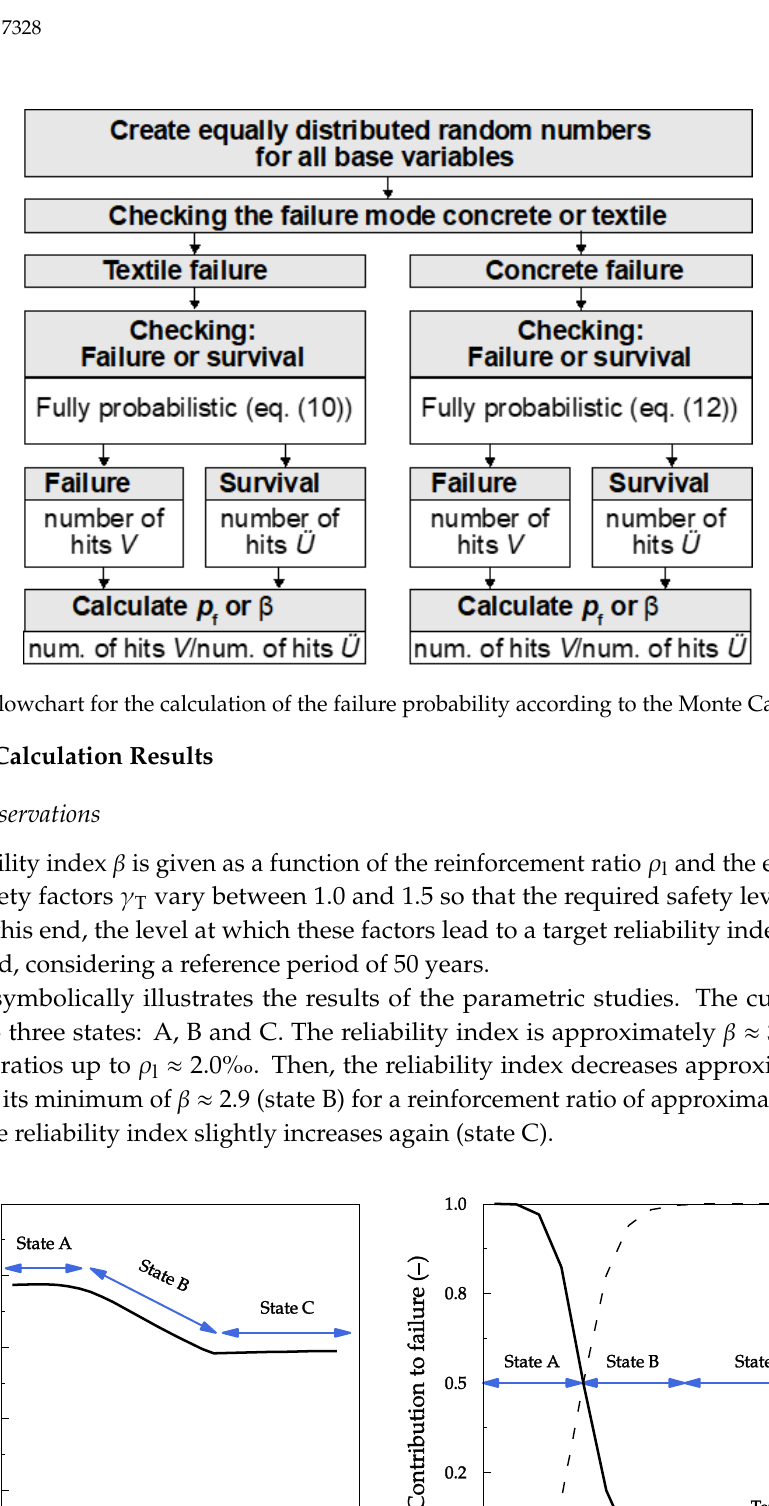
Figure 5. Flowchart for the calculation of the failure probability according to first-order reliability method (FORM) under the assumption of a linear σ–ε diagram for the concrete.